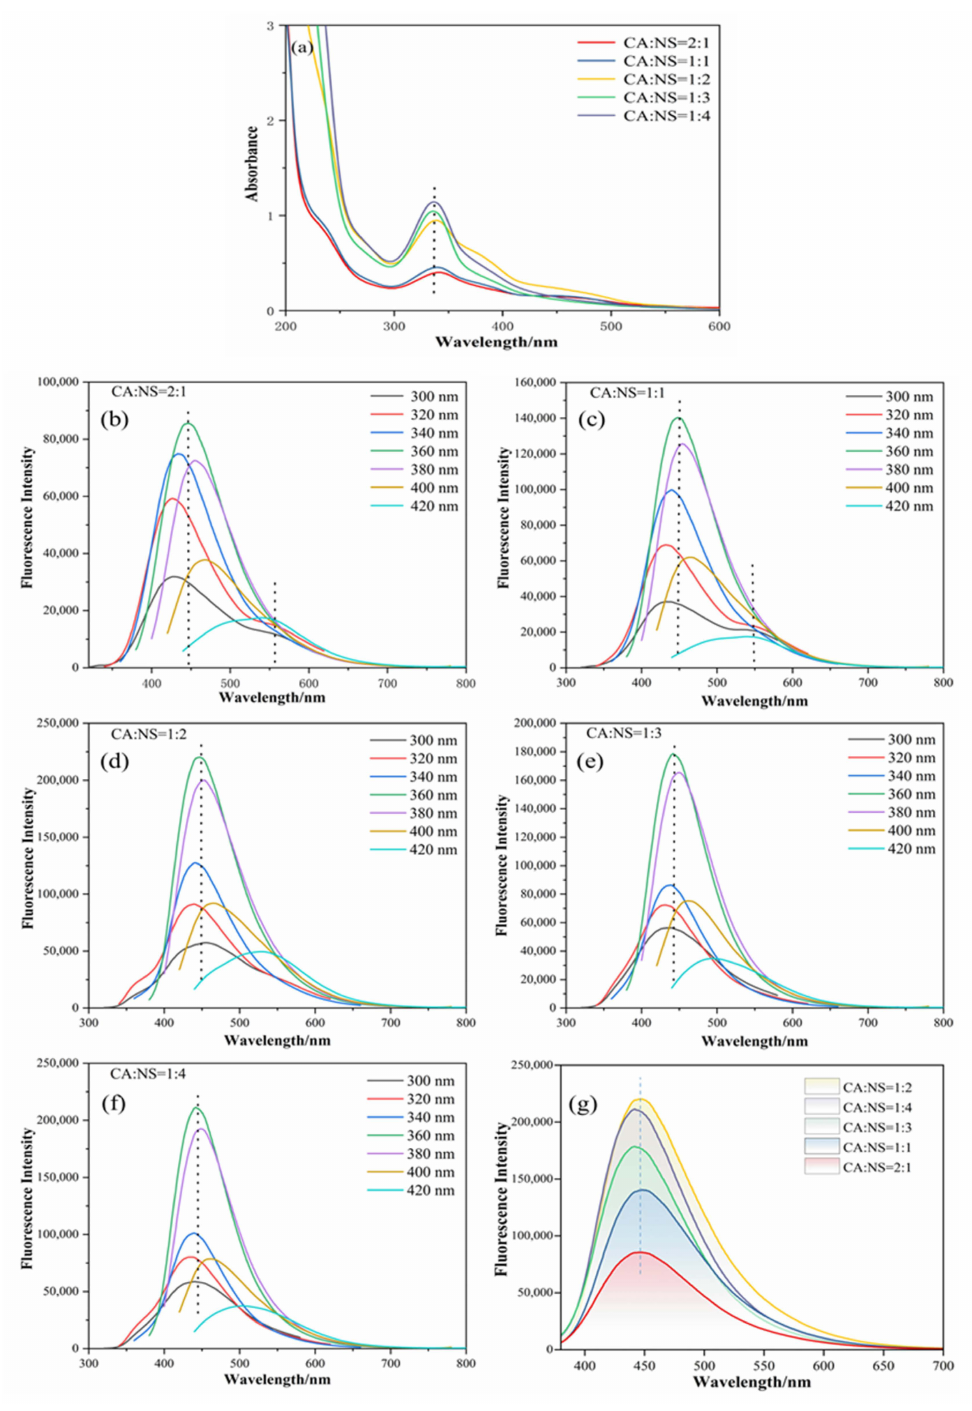
Figure 3. UV-Vis absorption spectra of different components of N,S-CDs ( a ), fluorescence emission spectra ( b – f ) at different excitation wavelengths from 300 to 420 nm, and emission spectra of each component at the optimal excitation wavelength of 360 nm ( g